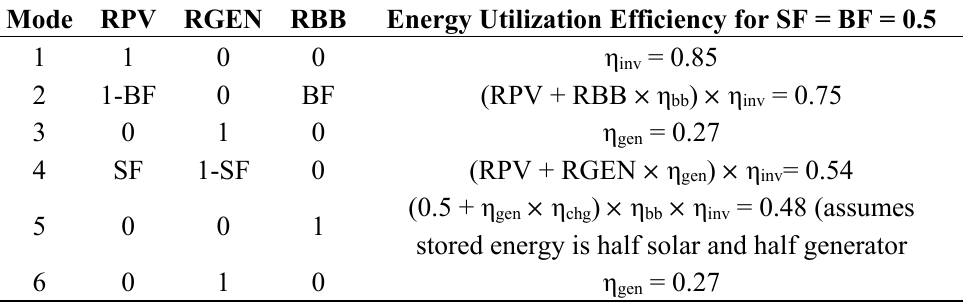
Table 3. Steady state energy conversion efficiencies for each of the modes.